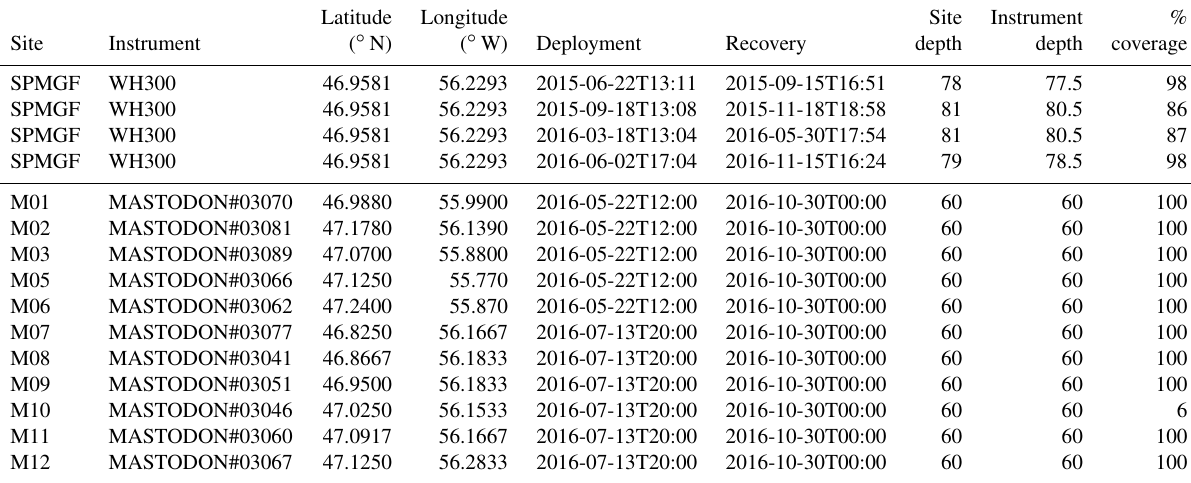
Table B6. IFREMER data collection